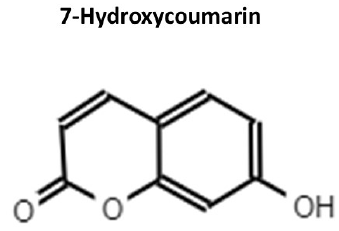
Figure 2. Chemical structure of UMB.